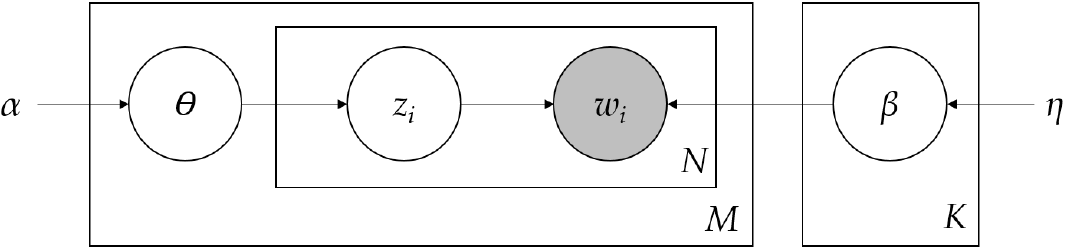
Figure 1. Plate notation of the LDA (based on [19]). The shaded node represents the observed variable, a word w i in a document. The latent variables z i for the topic assignment, θ for the document-topic distribution and β for the topic-term distribution are shown as clear